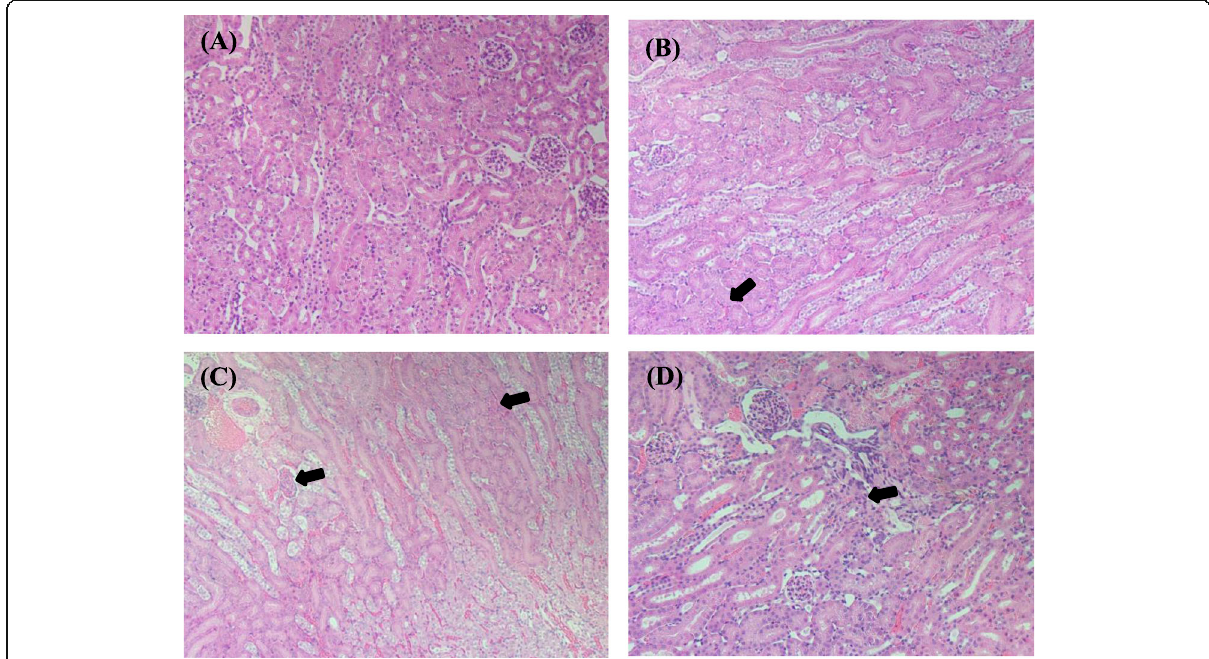
Fig. 5 Histologic analysis of kidney tissues from gold nanoparticle – treated mice. At 24-h post-IV administration of only GnP10 ( a ), GnP10 with